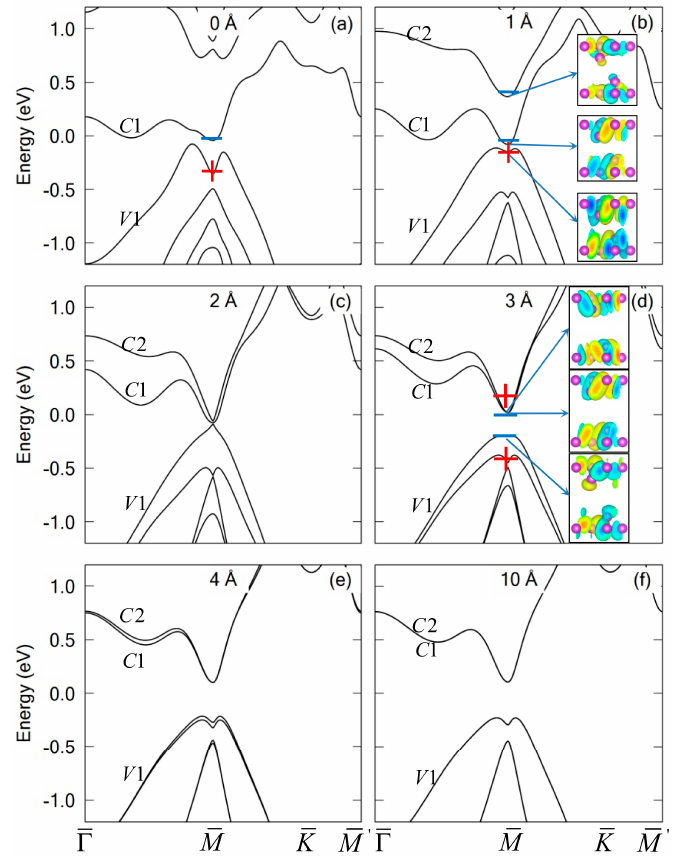
Figure 2. Band structures of double-bilayer bismuthene by scaling the inter-bilayer spacing as indicated. The parity of some states at the zone center is indicated. The insets in ( b ) and ( d ) show the real parts of the wave functions for the states at the zone center as